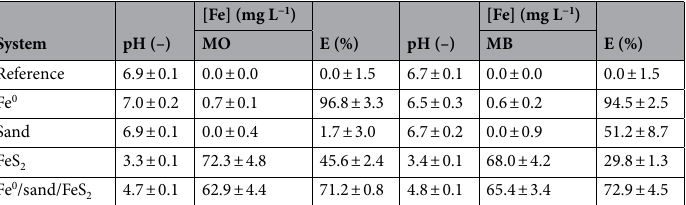
Table 4. Variations of the pH value, the iron concentration ([Fe]) and the extent of dye discoloration (E) in the single-aggregate and the ternary systems after 41 days of equilibration.